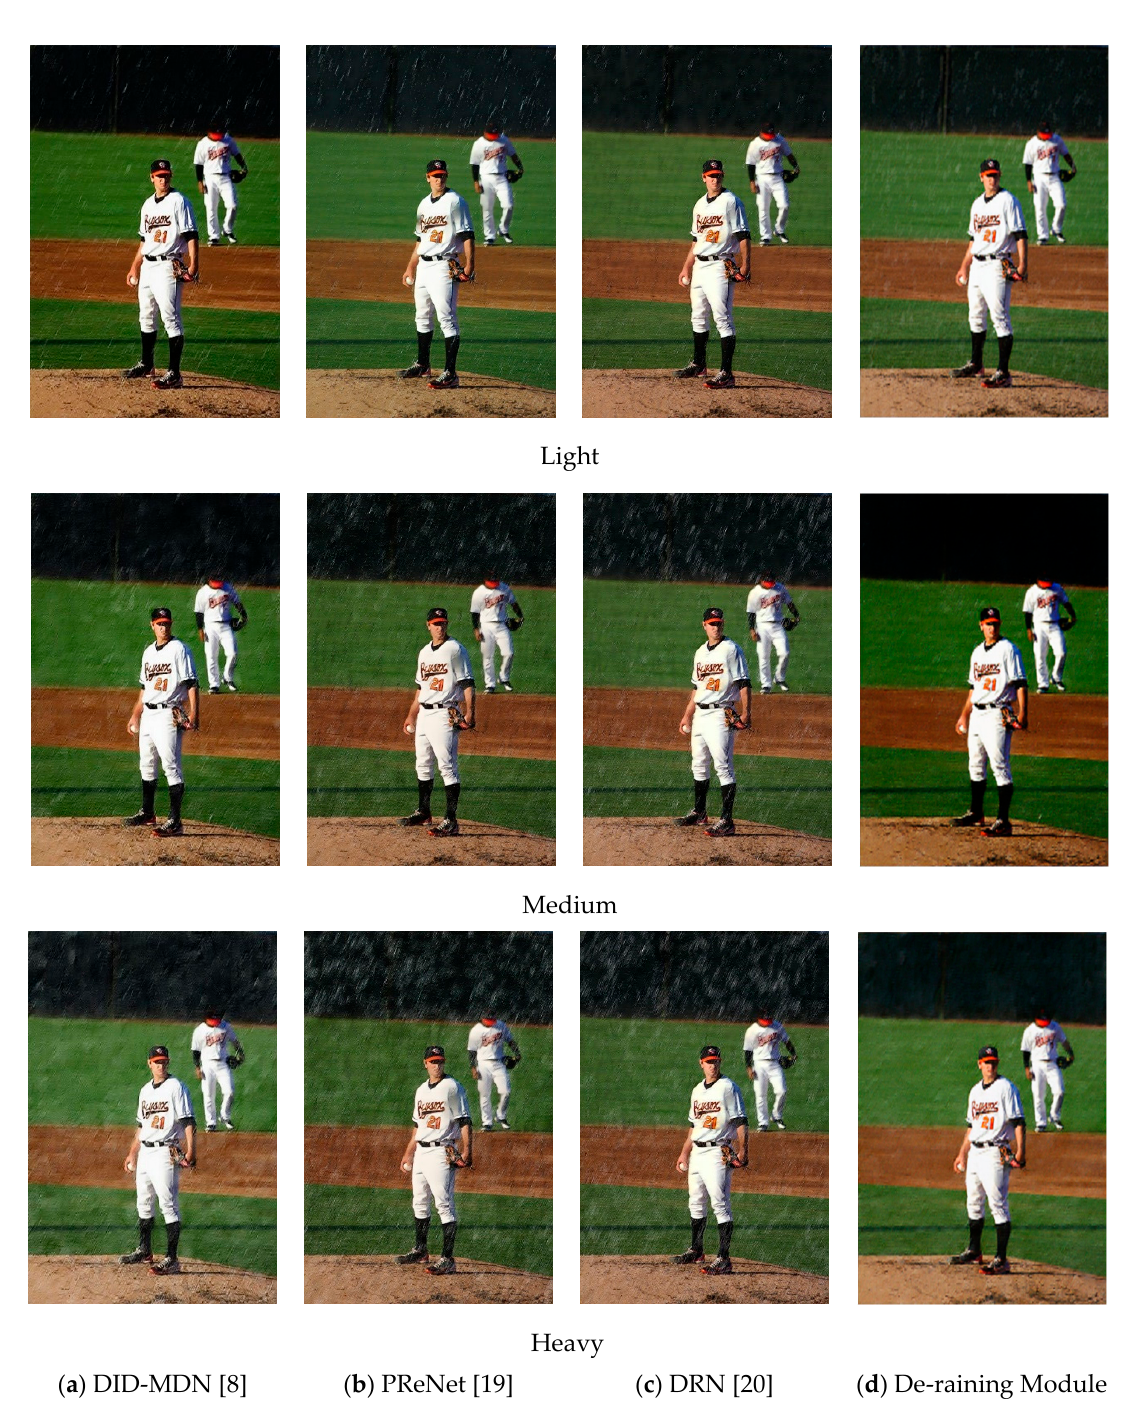
Figure 10. Rain-streak removal results on sample images from the synthetic datasets.